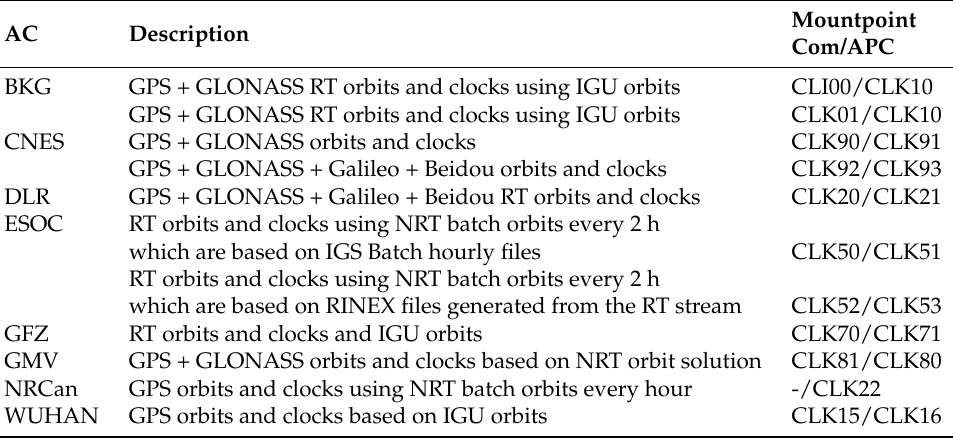
Table 1. Correction streams from the IGS RTS by individual